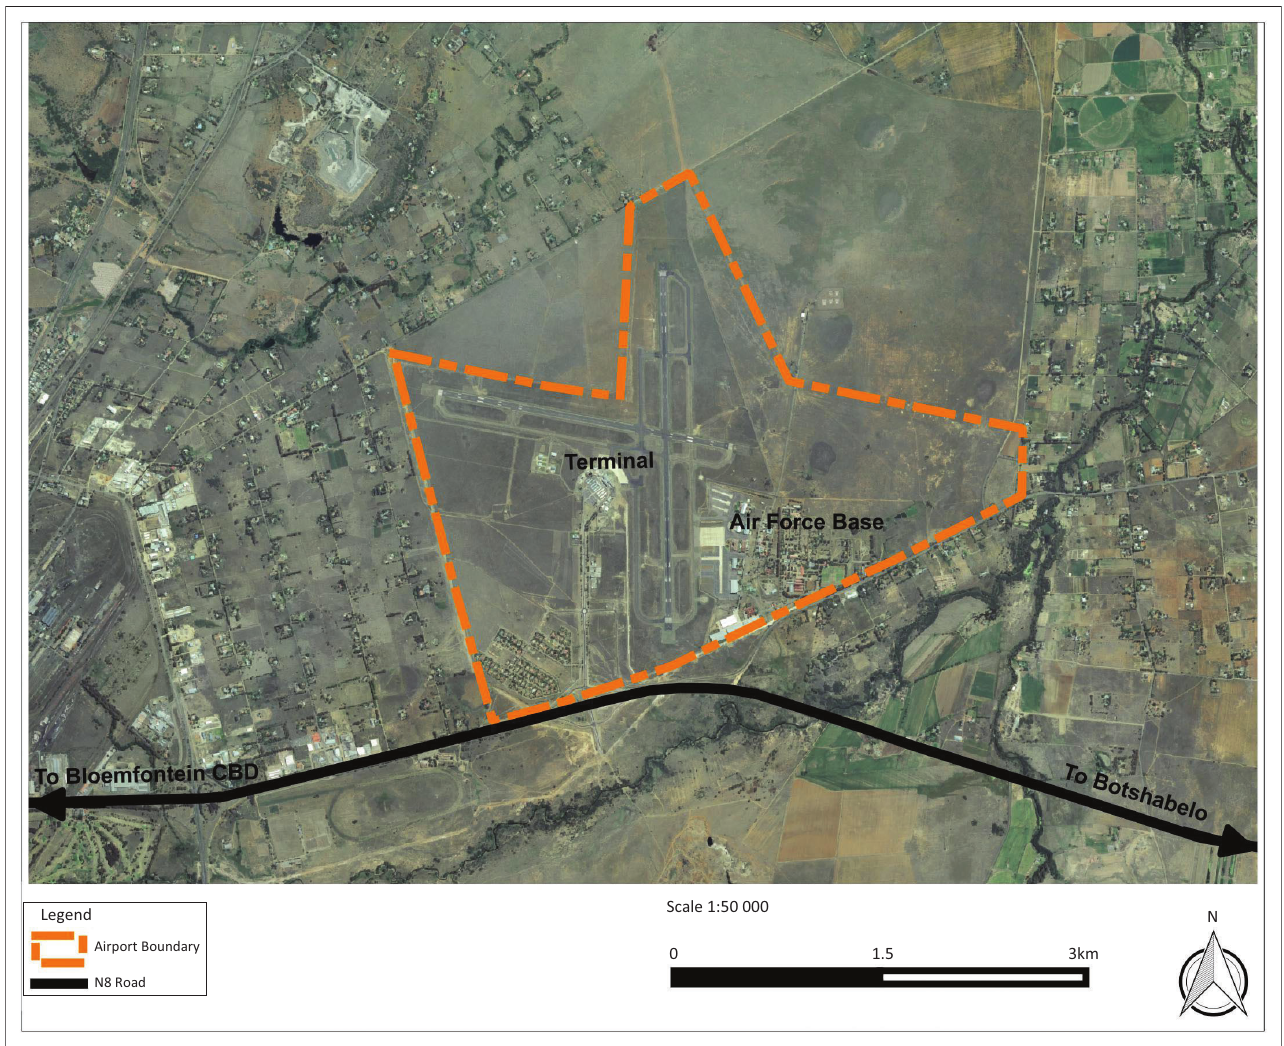
FIGURE 1: Location of Bram Fischer International